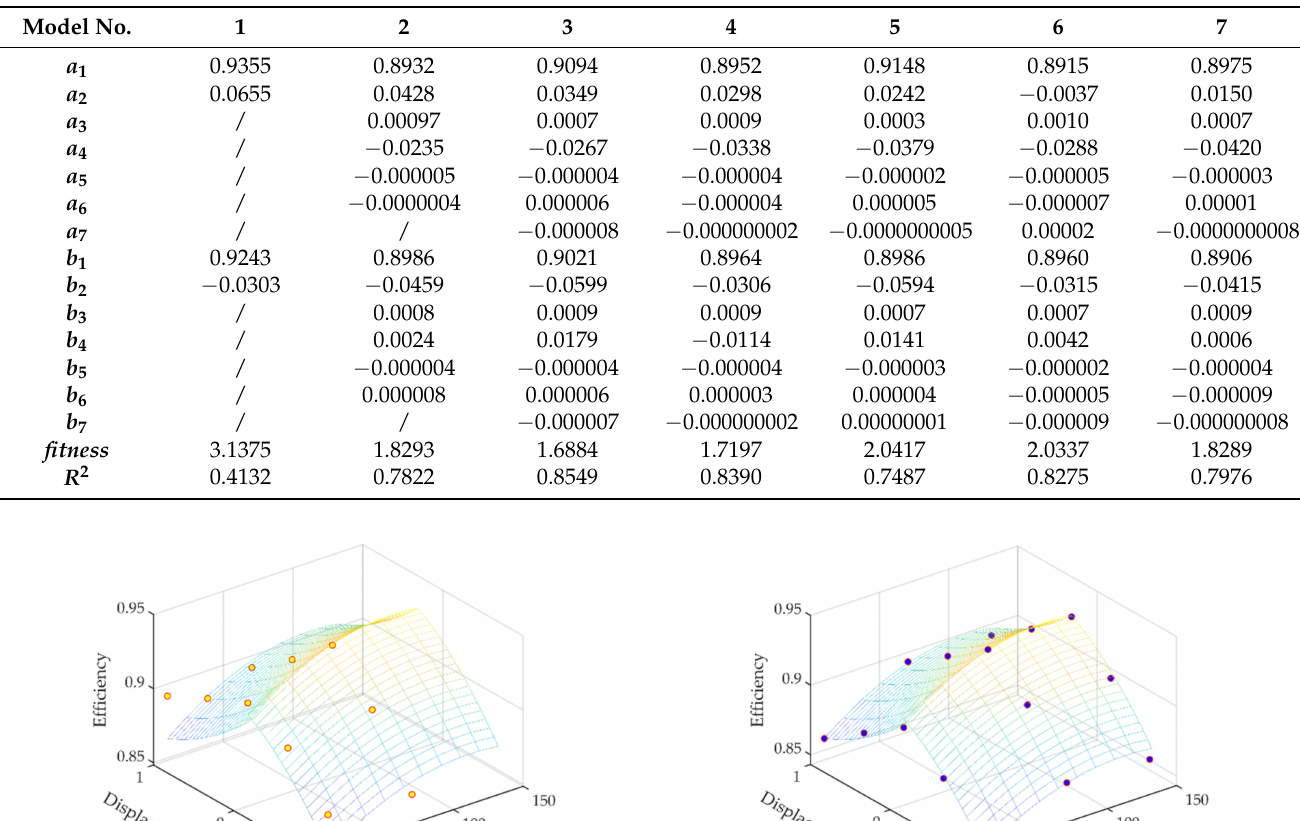
Table 3. Parameter identification results of I-GA-based models.